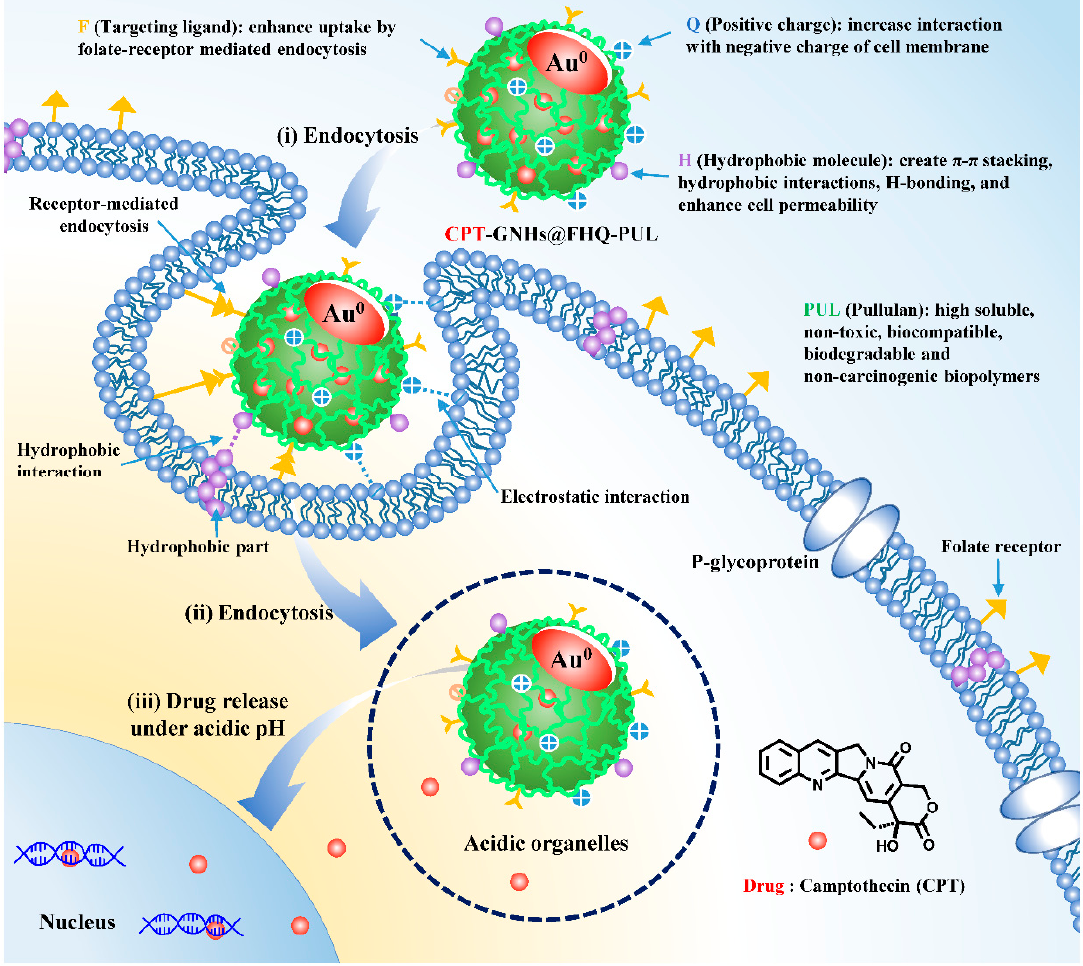
Figure 1. The proposed actions and pH-triggered intracellular release of CPT from CPT-GNHs@FHQ-PUL in cancer cells.